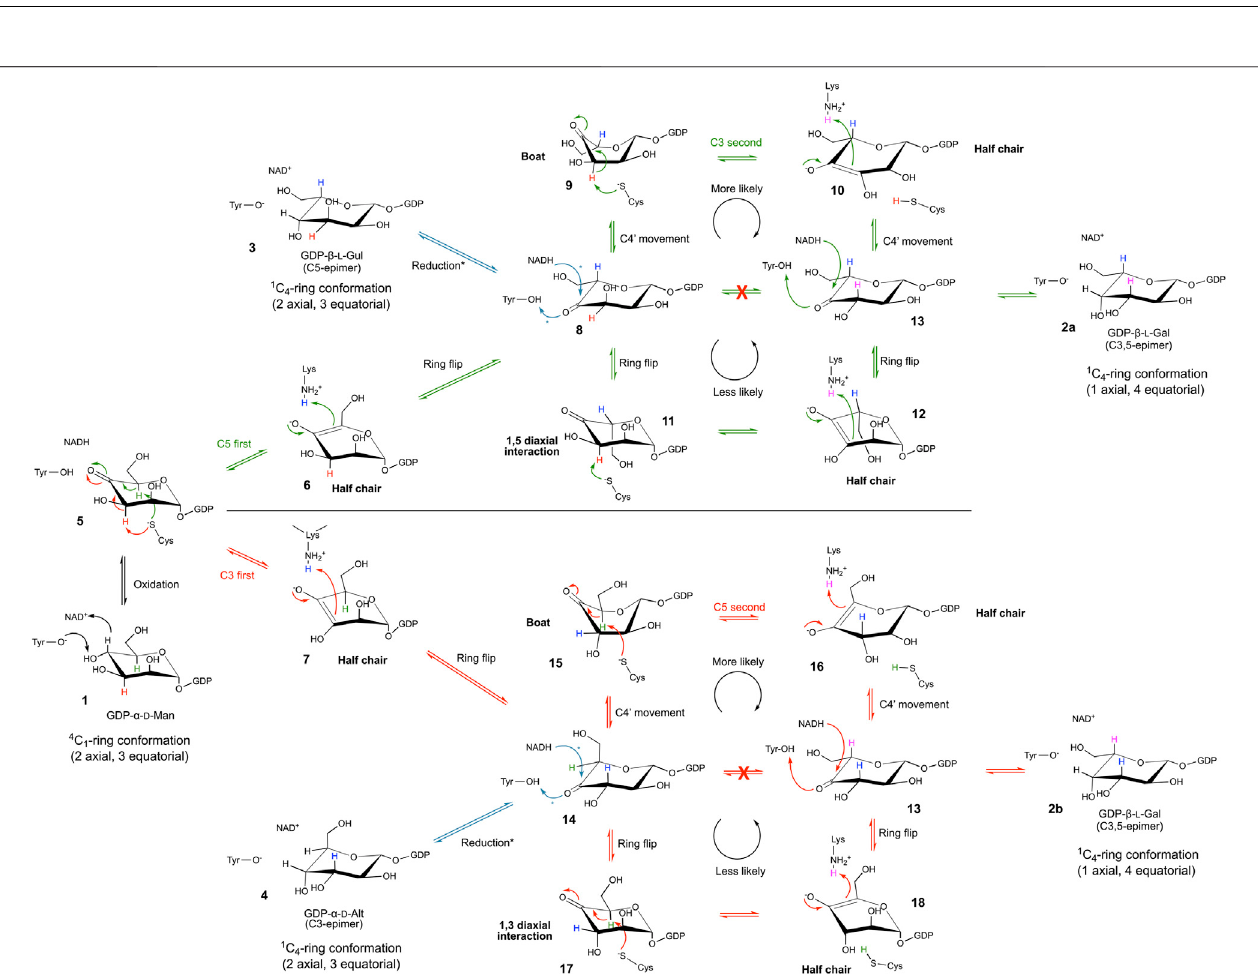
FIGURE 5 | Mechanism of the GDP-mannose 3,5-epimerase. The epimerization reaction results in equilibrium between GDP-Man, GDP- L -Gal, GDP- L -Gul and GDP- D -Alt.